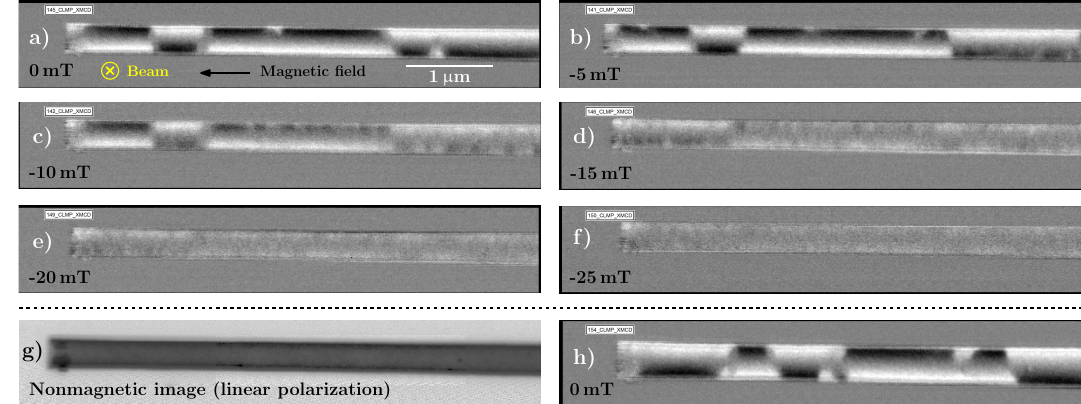
Fig. 3: STXM under external magnetic field - anisotropy strength determina- tion . a)-f) XMCD magnetic images (Co-L edge, same contrast range 15%) under 3 axial magnetic field. With increasing the field magnitude the STXM contrast van- ishes, showing that magnetization rotates towards the axial direction. Around 25 mT is needed for the saturation of tubes along the axial direction. Field of view a)-g) 6.0 × 1.0 µ m 2 and h) 4.8 × 0.8 µ m 2 . g) Non-magnetic STXM image (linear polar- ization of X-rays) highlighting the tubular structure. h) XMCD image after remov- ing magnetic field (after sequence a-f). Even at zero field, the transition between neighbouring domains is not as sharp as in XMCD-PEEM images; this we attribute to sample ageing (STXM done 1 year after